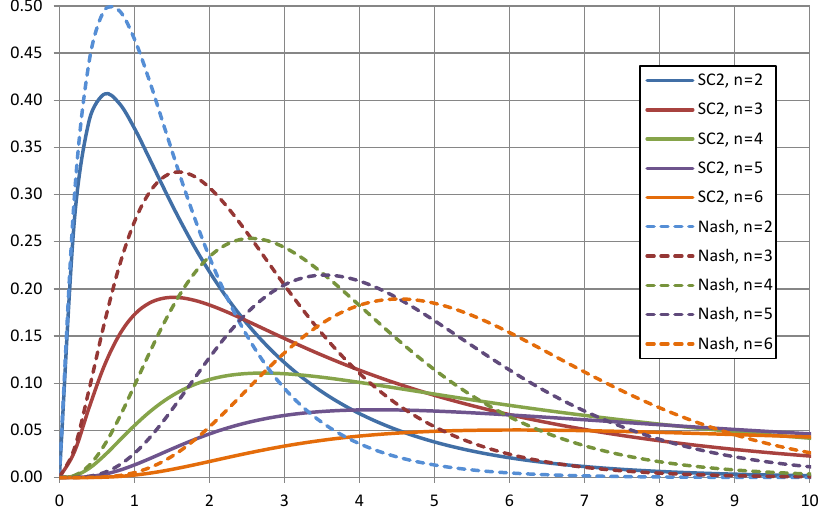
Figure 6. Comparison of IUH in SC2 and Nash models ( k SC2 = 1).